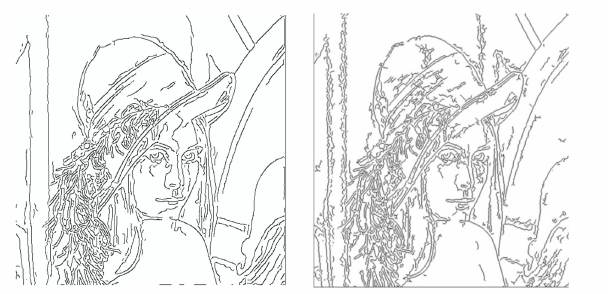
Figure 3. Comparison of the proposed edge detection method and the method in [14] σ n = 15. The proposed method ( left ); the method in [14] ( right